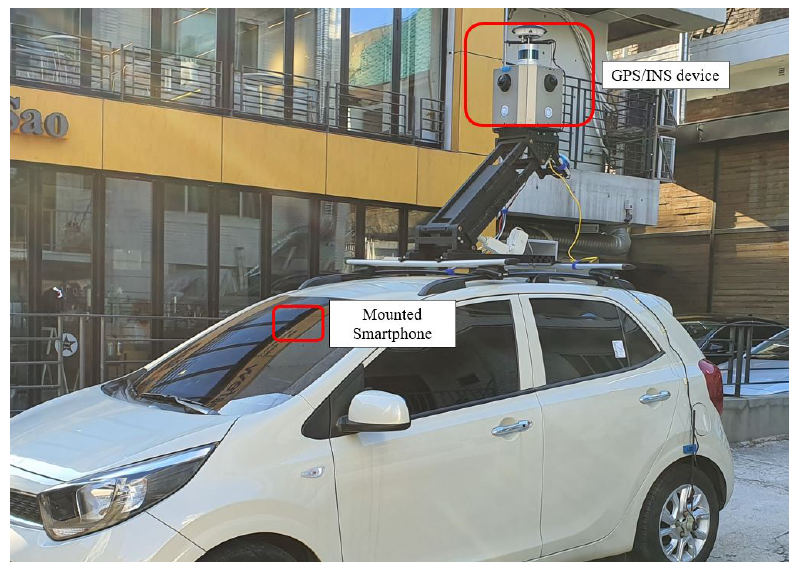
Figure 8. Setting of experimental devices.